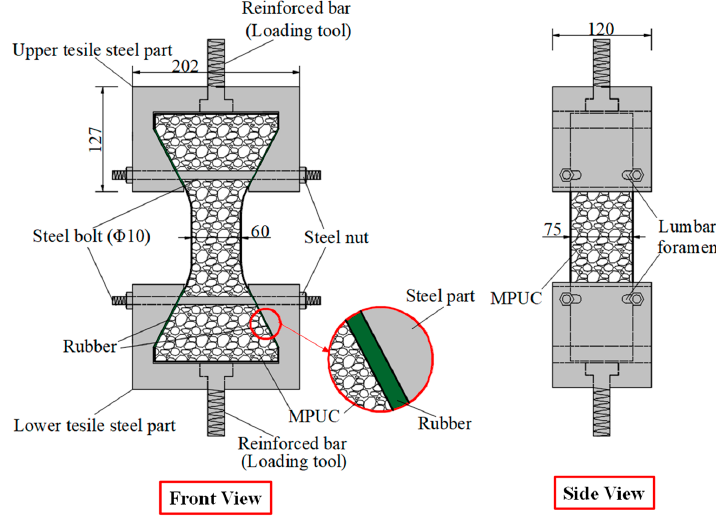
Table 3. Comparison of MPUC contact stretching schemes.